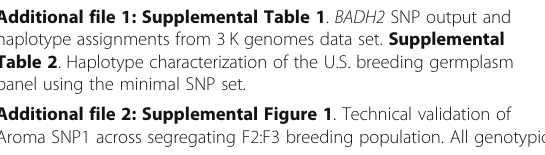
Table 2 . Haplotype characterization of the U.S. breeding germplasm panel using the minimal SNP set. Additional file 2: Supplemental Figure 1 . Technical validation of Aroma SNP1 across segregating F2:F3 breeding population. All